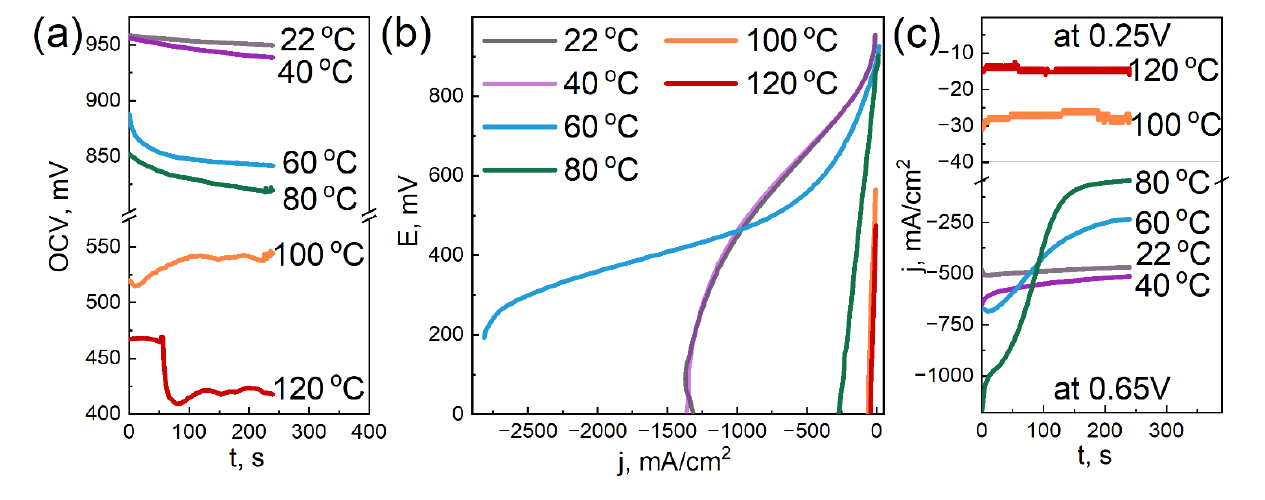
Figure 6. Electrochemical characteristics of the MEA with the Aquivion ® -type membrane (EW = 897 g-eq/mol) without DNDs at different temperatures: open circuit voltage (OCV) vs. time ( a ); voltammograms ( b ); and current density in the potentiostatic mode at voltages of 0.65 and 0.25 V vs. time ( c ).